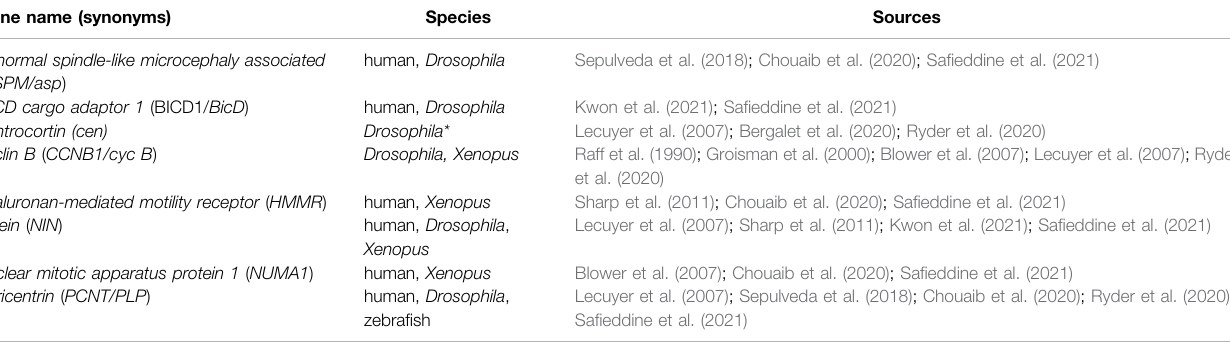
TABLE 1 | Conserved mRNAs localizing to centrosomes.